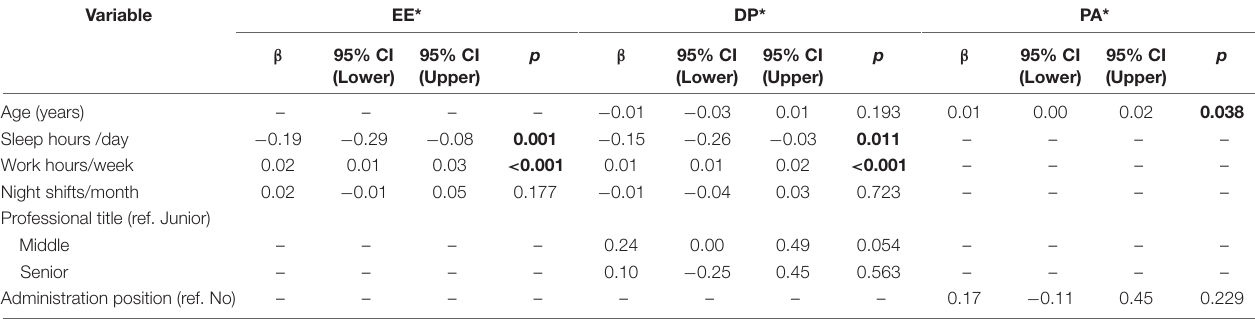
TABLE 5 | Multilevel analysis of associated factors for burnout among 513 female endocrinologists.